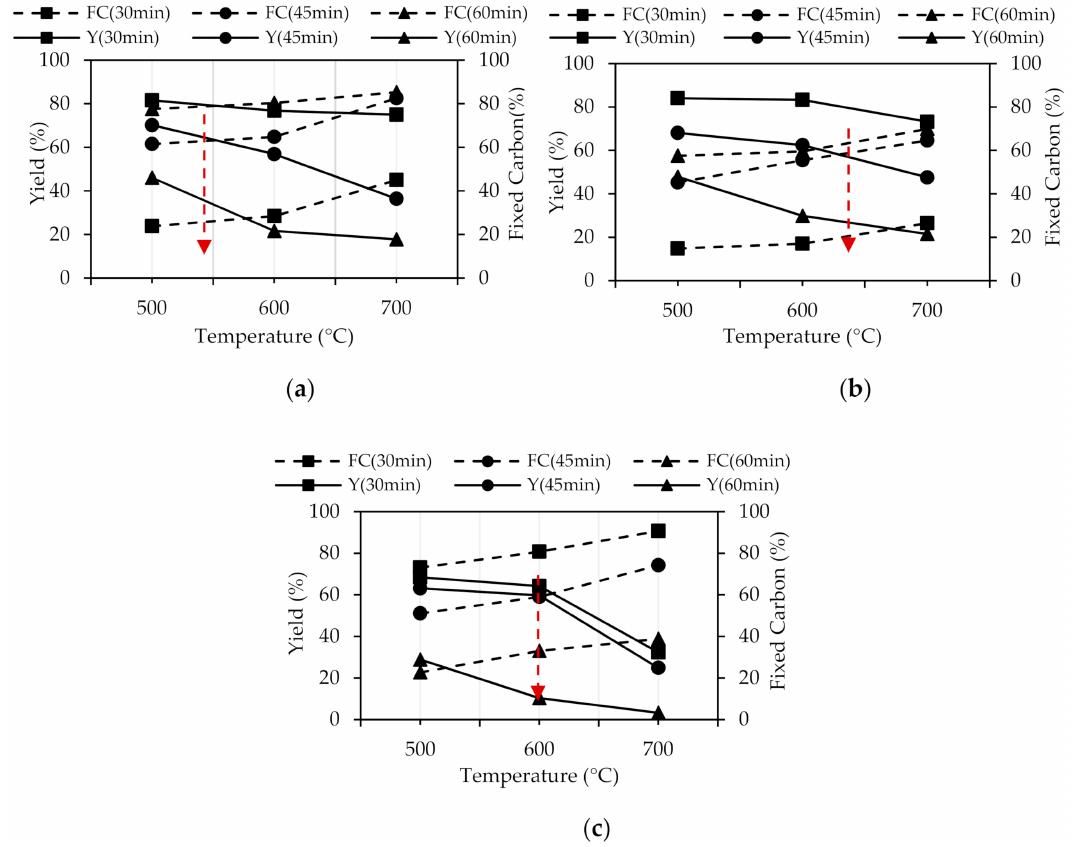
Figure 1. Yield vs. fixed carbon of biochar: ( a ) peanut shell (BCM), ( b ) “chonta” pulp (BCH) and ( c ) corn cob